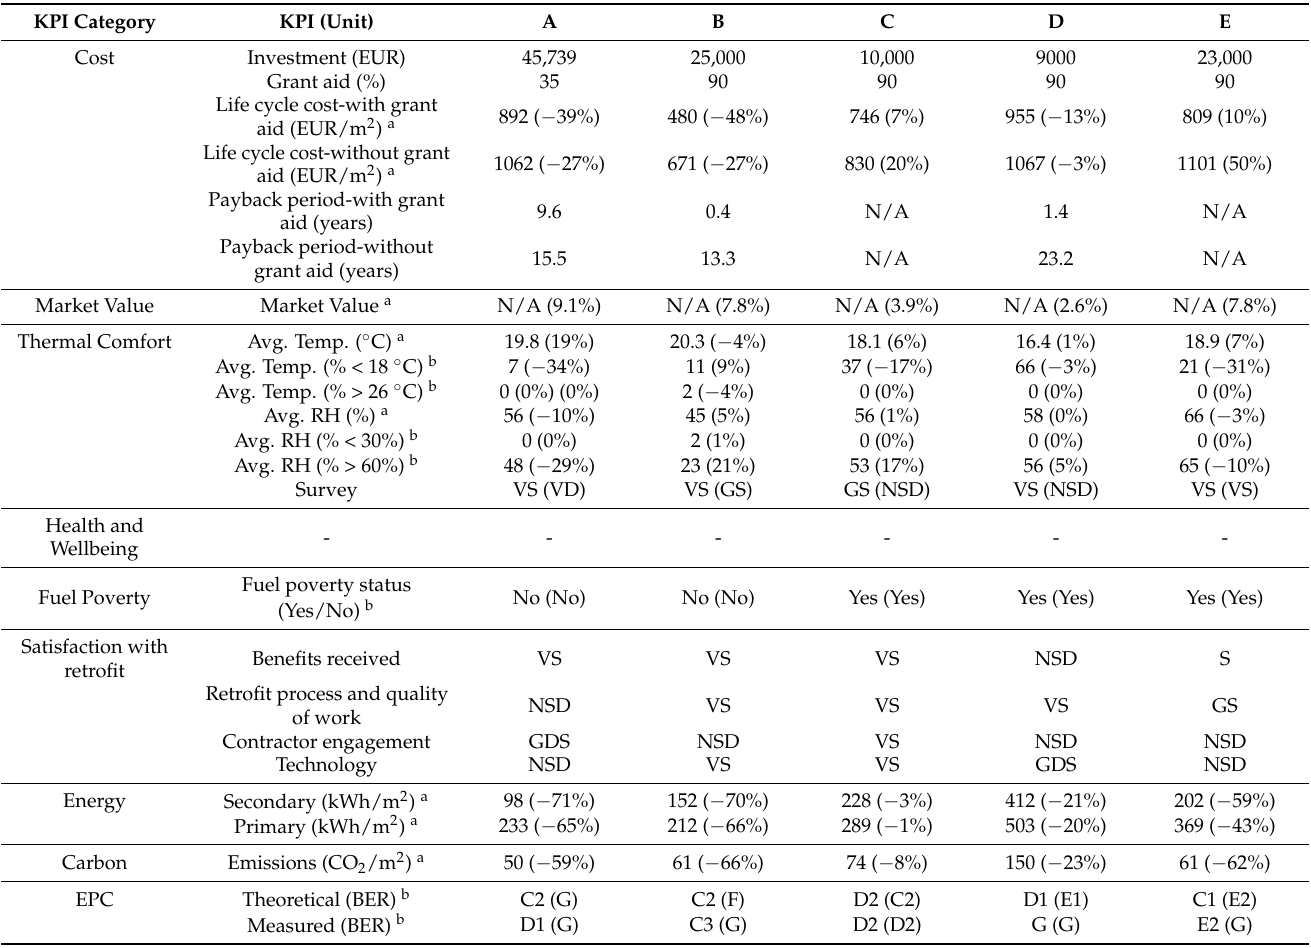
Table 3. Post-retrofit KPI results for each of the case study buildings. Values in brackets are the a percentage change of post-retrofit results relative to the pre-retrofit results or b pre-retrofit